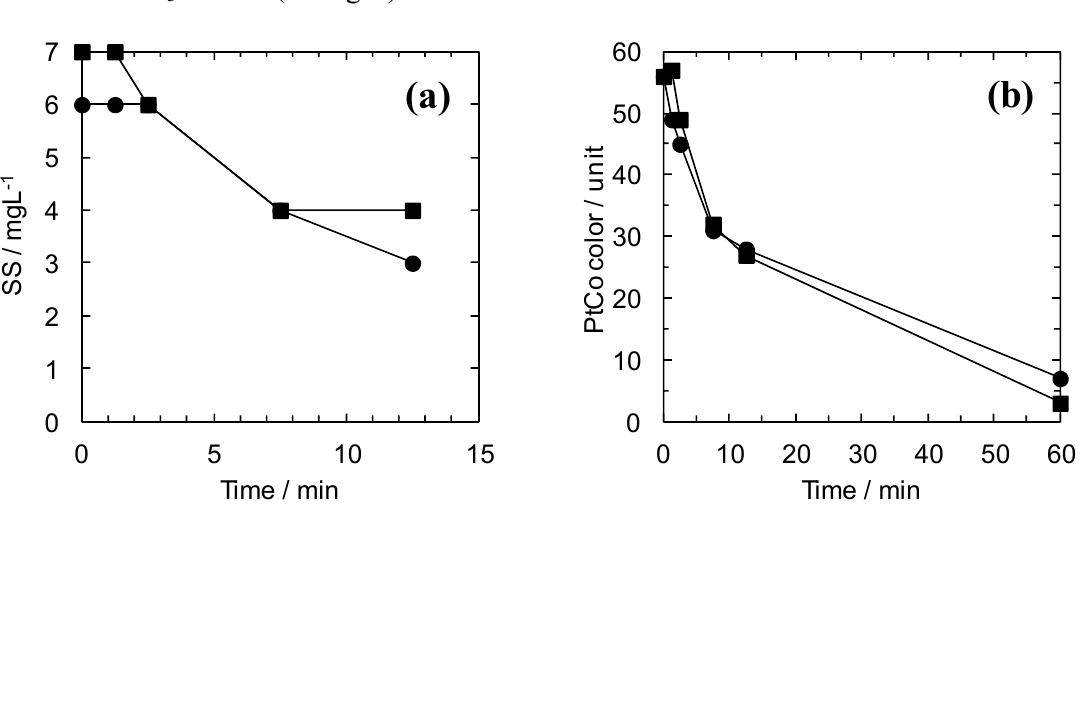
bubbling (10 mg/L); solid circles: 3